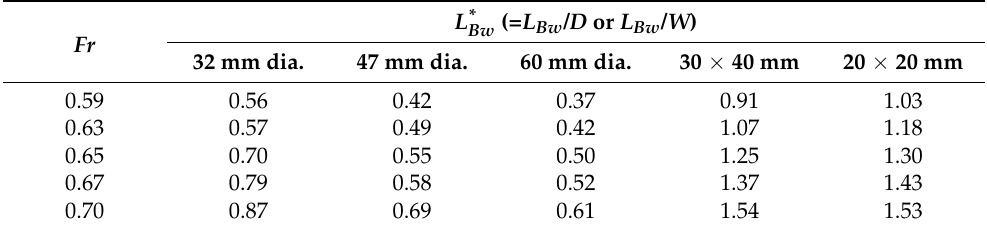
Table 3. Non-dimensional surface bow-wave